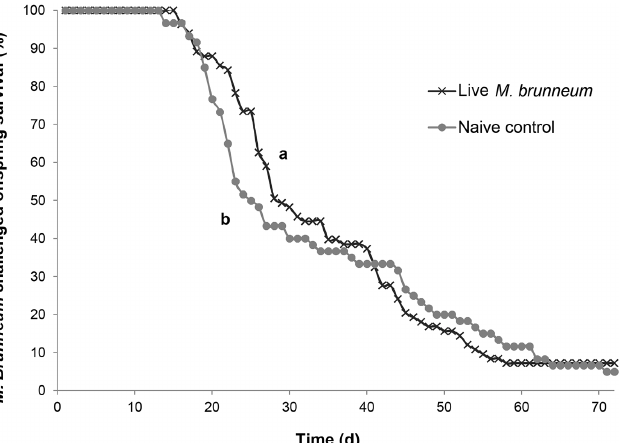
Fig 2. Survival curves for offspring of the live M . brunneum treatment. Percentages of male and female (merged) offspring treated with M . brunneum surviving over time whose mothers were challenged with either a living dose of M . brunneum or a control treatment (naive control). Different letters signify significant differences in survival curves between treatments ( χ 2 1 = 9.07, p =